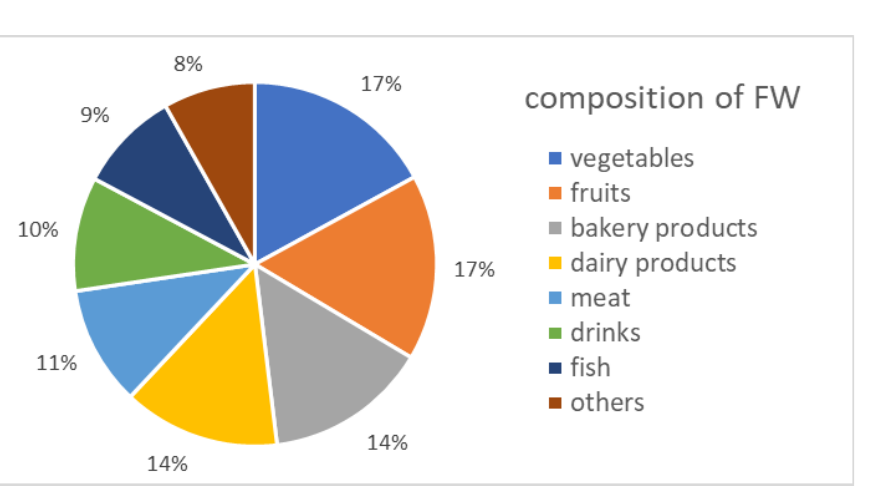
Figure 5. questionnaire—estimated composition of food waste (aggregated in kg). Figure 5. Questionnaire—estimated composition of food waste (aggregated in kg). Ultra-fresh products and food without a best-before date like vegetables (17%), fruits (17%), bakery products (14%) and dairy products (14%) are most often discarded. In the diary, the proportion of fruit was ten percentage points higher and none of the diary keepers disposed fish. In addition, the “homemade meals” category has been added; 10% of FW is generated in this category. The diary also recorded whether food was disposed in a processed or unprocessed state. 23% of the amount of FW was disposed in a processed state, which was accompanied by a correspondingly higher input of energy and